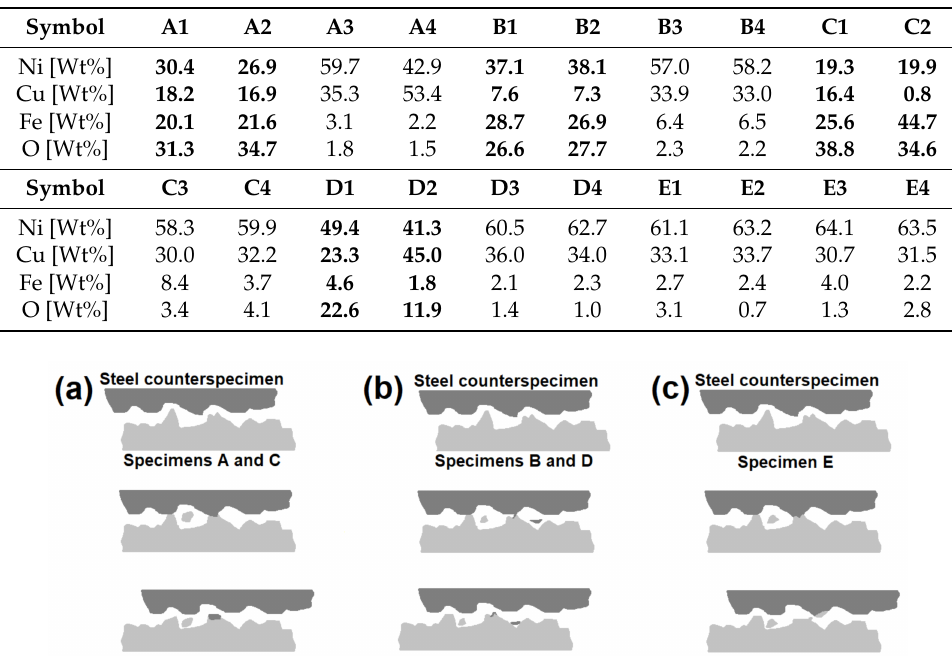
Table 4. Results of chemical composition analysis of spots marked in Figure 8.